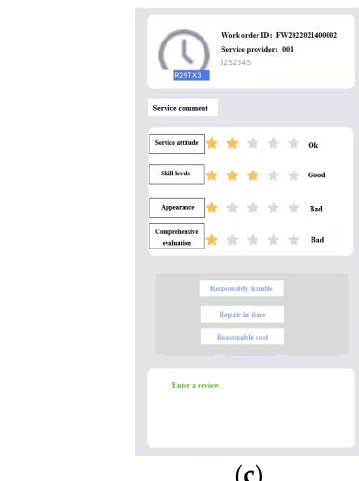
Figure 7. Operation and maintenance platform information management system. ( a ) Maintenance personnel information management; ( b ) Order History Repair Record Details.